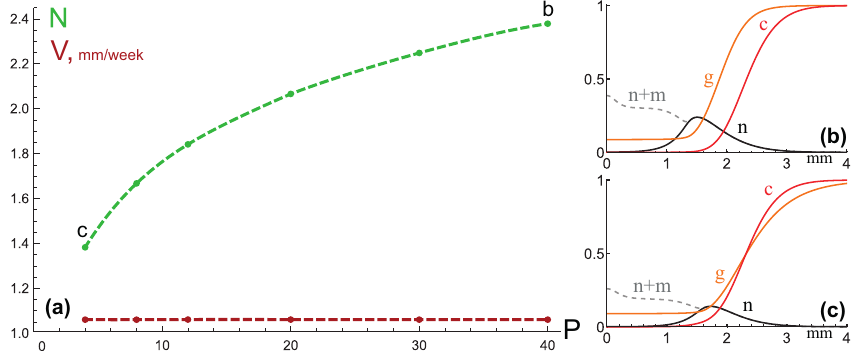
Figure 4. ( a ) The red dots denote the values of tumor growth speed V ; the green dots denote the values of number of tumor cells N , which were obtained numerically in the simulations of Equation (1) with the neglect of hyperbolic terms (i.e., I = 0) under designated values of angiogenesis parameter P , values of other parameters, taken from the basic set, space step h = 0.1, and time step τ = 0.01. The dashed lines are interpolations of data points. ( b , c ) The distributions of the model variables on the 20th day of simulations under P = 40 and P = 4